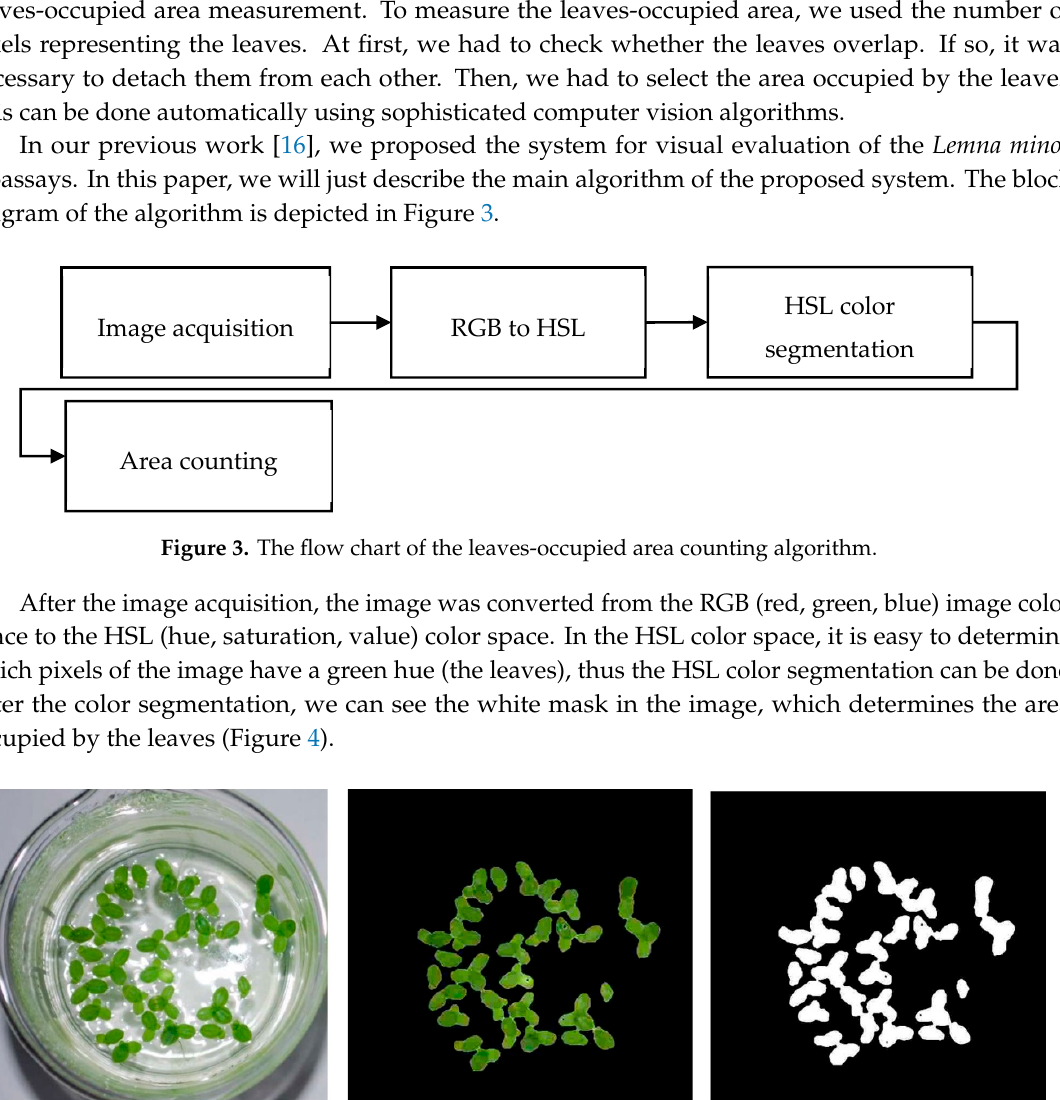
Figure 4. Original image ( a ), image of segmented leaves ( b ), image of the mask of the leaves ( c ).